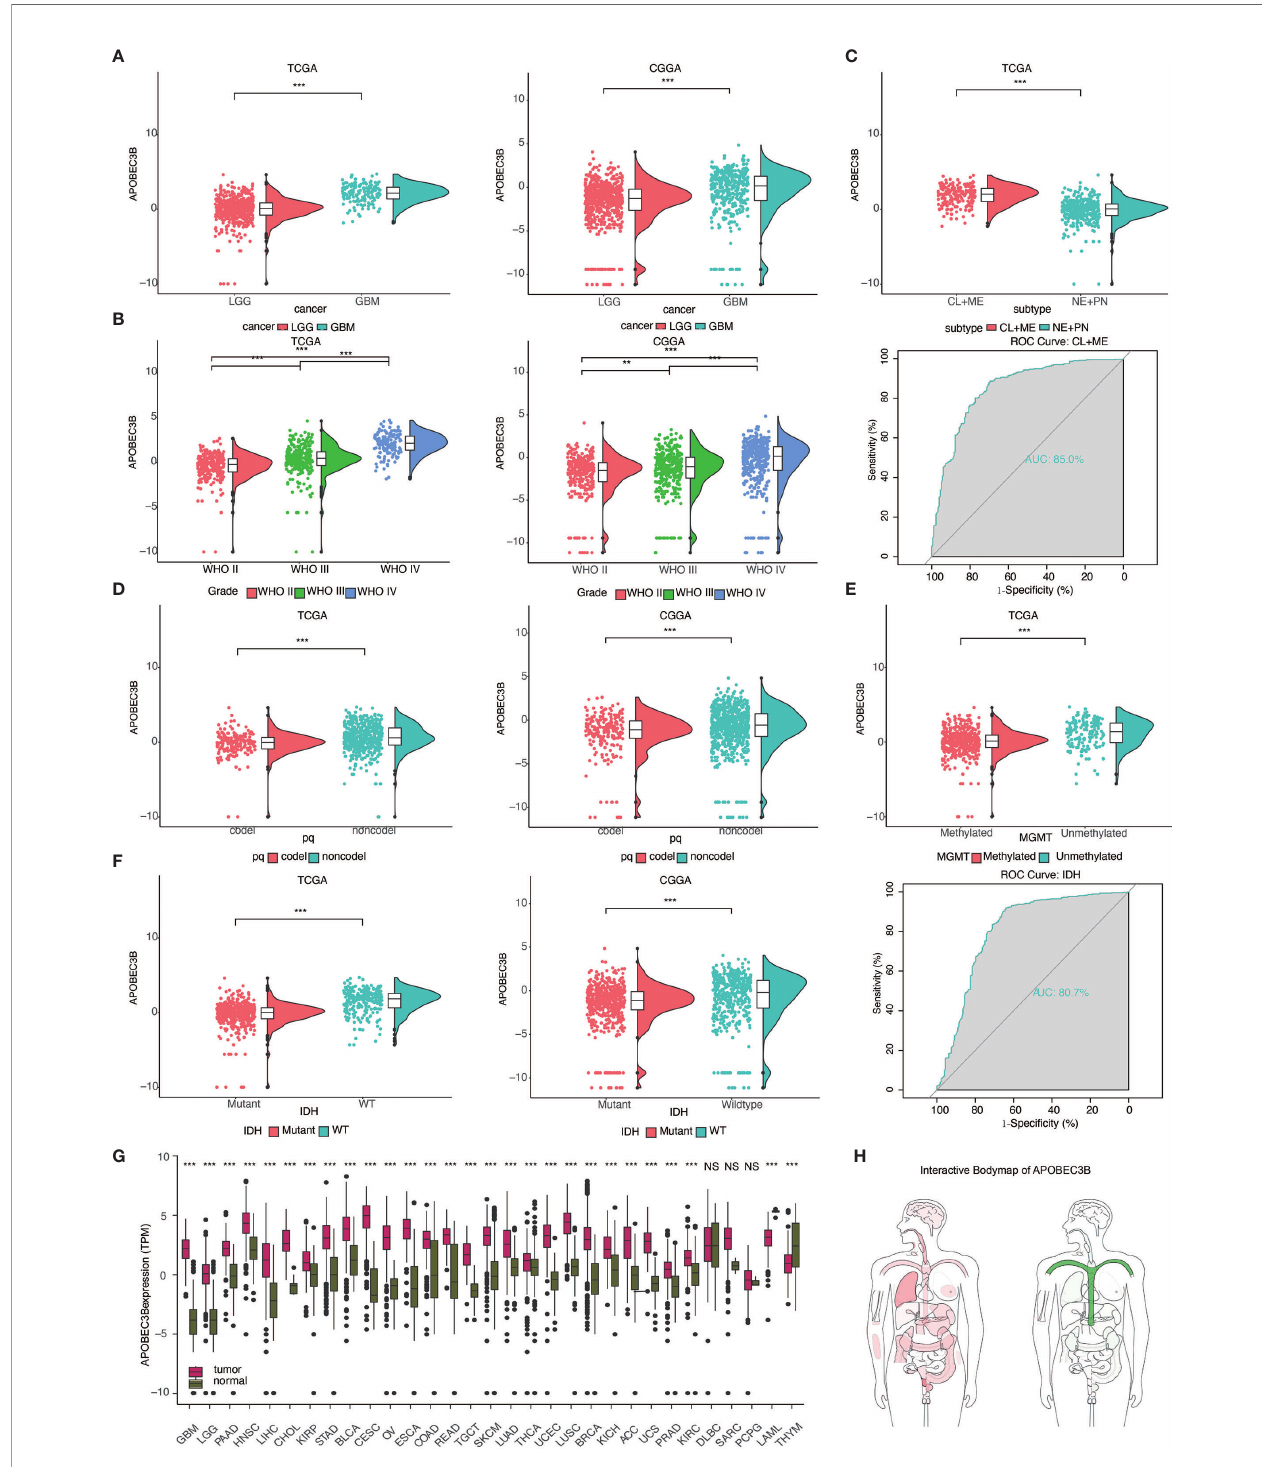
FIGURE 1 | The expression level of APOBEC3B is increased in aggressive glioma and other cancers. Analysis of APOBEC3B mRNA levels in (A) LGG and GBM (B) WHO grade II – IV gliomas (D) 1p19q codeletion and non-codeletion from TCGA and CGGA datasets. (C) APOBEC3B expression in distinct subclasses(upper), ROC curve indicating sensitivity and speci fi city of APOBEC3B expression as a discriminative biomarker for CL+ME subtypes and GBM (lower). (E) APOBEC3B expression in MGMT methylated and unmethylated. (F) Analysis of APOBEC3B level in IDH mutant and wildtype from TCGA and CGGA. ROC curve indicates the sensitivity and speci fi city of APOBEC3B expression as a diagnostic biomarker for discriminate IDH mutation from non-IDH mutation. (G) APOBEC3B mRNA expression levels in pan-cancer. (H) The median expression of tumor (red) and normal (green) samples in bodymap. NS, Not Statistically Signi fi cant; *P < 0.05; **P < 0.01; ***P < 0.001; ****P <